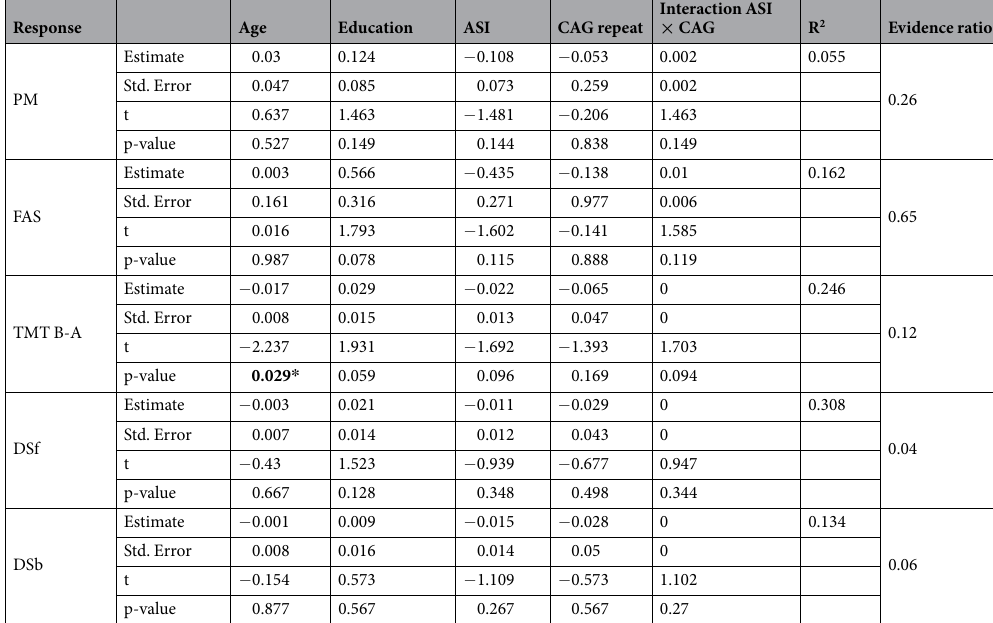
Table 4. Within-patient regression analyses. Significance levels: * p < 0.05. CAG repeats: cytosine-adenine- guanine